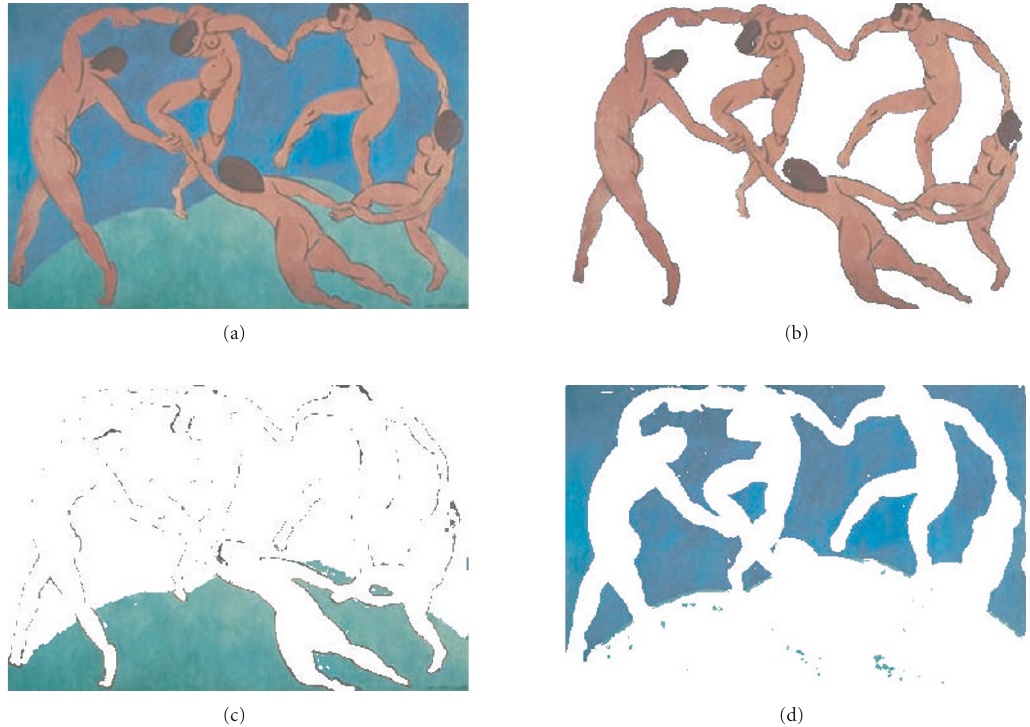
Figure 10: Matisse, Les danseurs . (a) Preprocessed image; (b) brown-orange-rose region; (c) green region; (d) blue region.